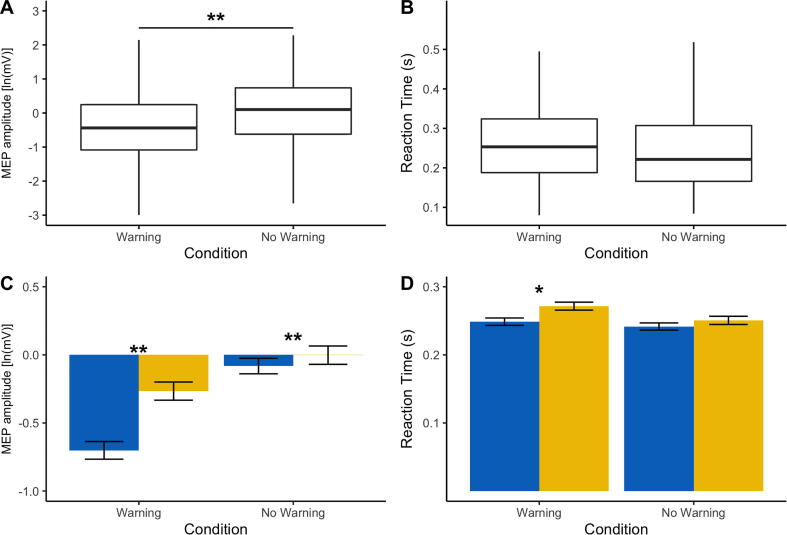
The effect of condition (Warning vs No Warning) and fatigue on motor evoked potential (MEP) amplitude and reaction time (RT). A, B. Boxplots for MEP amplitude and RT across all stroke survivors for each condition indicating a significant effect of condition on MEP amplitude but not on RT. C, D. Bar plots with standard error bars representing MEP amplitude and RT across both conditions with stroke survivors grouped based on their fatigue score. Fatigue was measured using the Fatigue Severity Scale (FSS-7). Low fatigue patients (FSS-7 < 4) are represented in blue and high fatigue patients (FSS > 4) are represented in yellow. The association between fatigue (FSS-7) and MEP amplitude for each time point is also shown. Significance levels are indicated by * (* < 0.05, ** < 0.001).